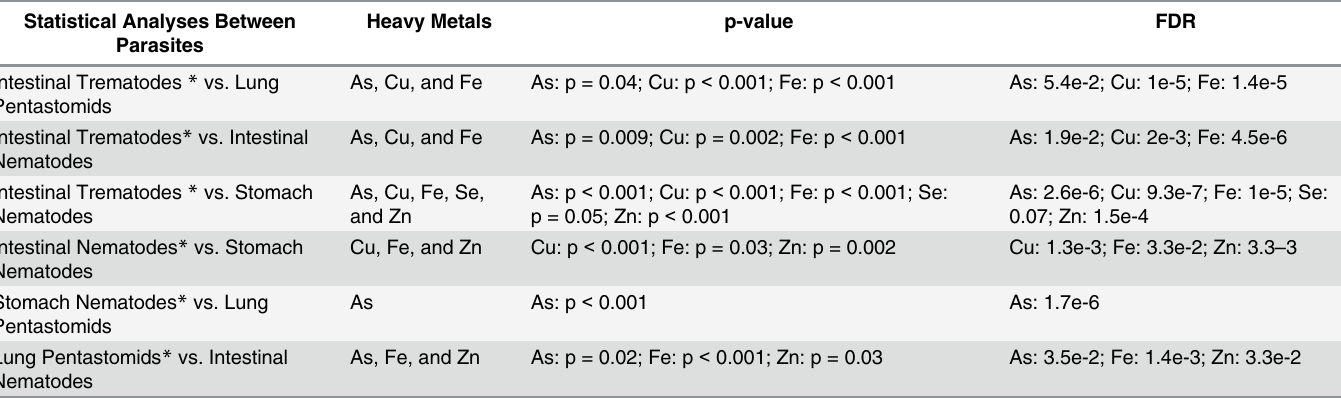
Table 4. Summary of statistically significant heavy metal variation among pentastomids, trematodes and nematodes. Parasites with significantly higher levels of heavy metal concentrations are marked with ( * ). Statistical analyses were performed with Wilcoxon-Signed Rank tests. FDRs are provided to show the projected percent of false predictions in the set of predictions.